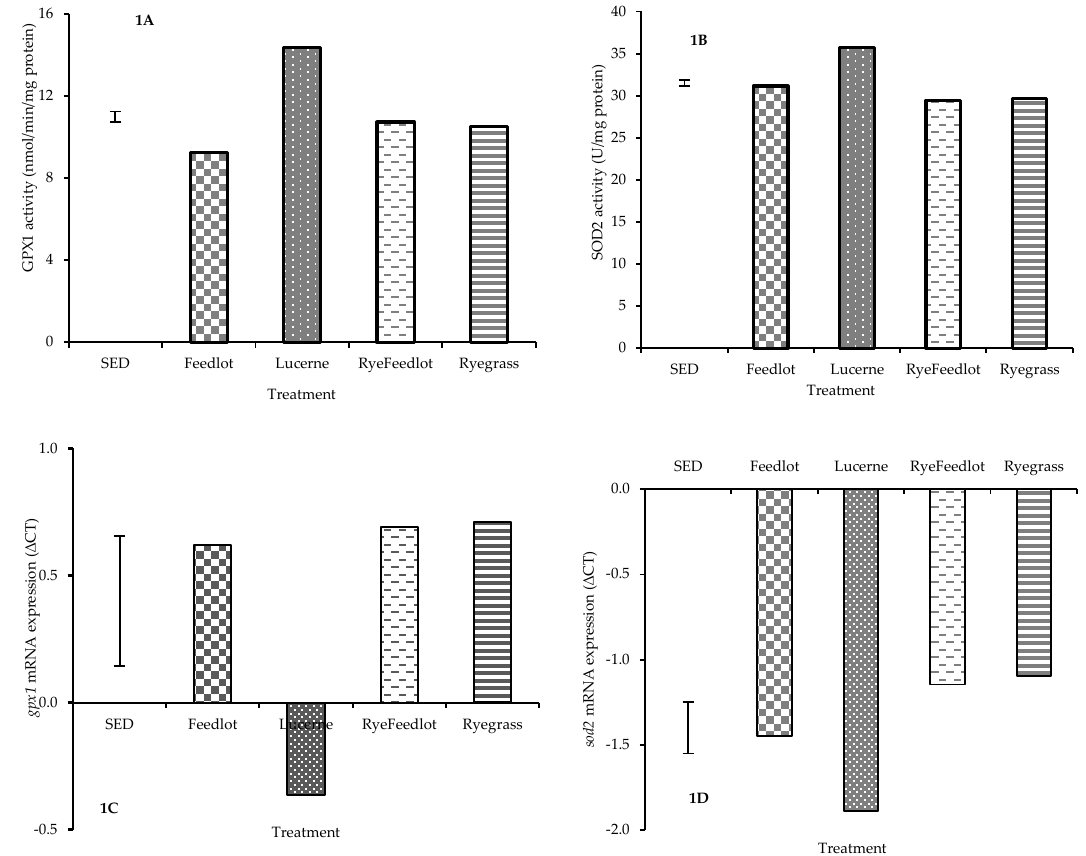
Figure 1. Dietary effects on muscle glutathione peroxidase 1 (GPX1) ( A ) and superoxide dismutase 2 (SOD2) ( B ) enzyme activities, and gpx1 ( C ) and sod2 ( D ) mRNA